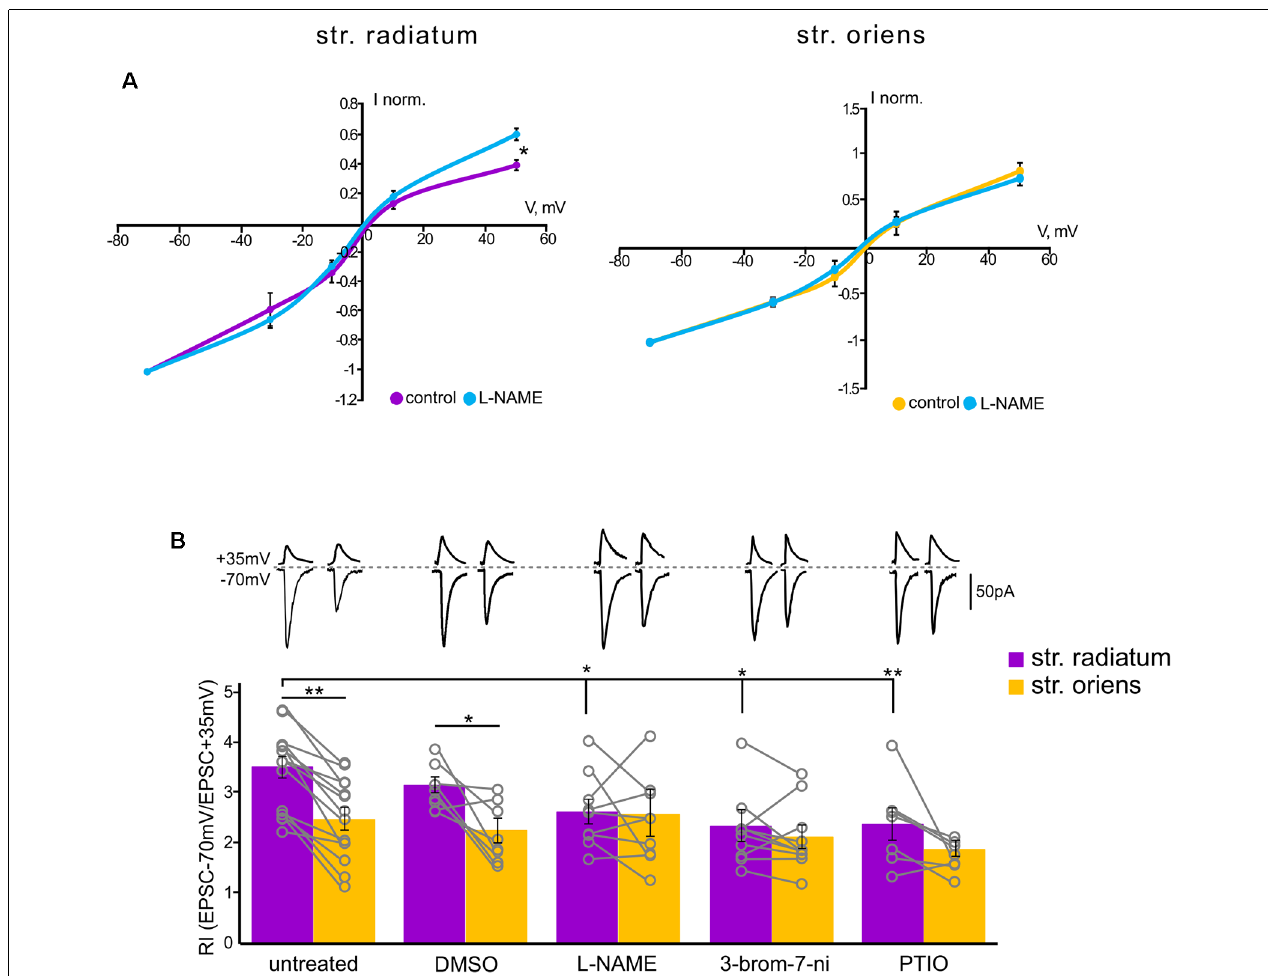
FIGURE 3 | Rectification properties of the apical and basal inputs under the NO-synthase inhibitors. (A) Current–voltage characteristics of apical (left) and basal (right) inputs in control cells ( n = 7) and under nitric oxide synthase (NOS) blockade ( n = 7), four animals, * p ≤ 0.05. (B) Comparison of rectification indices in stratum radiatum (purple) and stratum oriens (orange) in control cells ( n = 14 cells from nine animals) and under treatment with DMSO ( n = 8 cells from four animals), L-NAME ( n = 8 cells from six animals), 3-bromo-7-nitroindazole ( n = 10 cells from seven animals), and PTIO ( n = 7 cells from four animals). Top, example traces at +35 mV